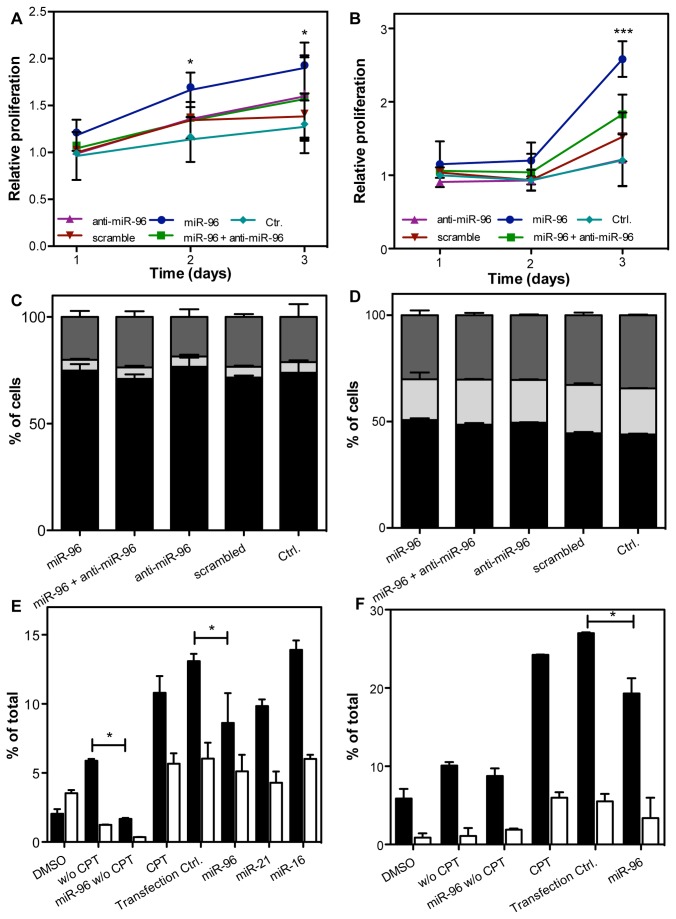
Functional role of miR-96 in vitro.LNCaP and DU145 cells were transfected with 10 nM pre-miR-96, anti-miR-96, pre-miR-NC #1 or combination of pre-miR-96 and anti-miR-96. The effect in (A) LNCaP and (B) DU145 on cell proliferation under serum starvation was measured by MTT assay over three days. All data were normalized on proliferation of control cultures on day 1 and are shown as mean (±SD) of three independent assays. *P <0.05, Two-way ANOVA. Cell cycle transition was measured by PI staining in transfected (C) LNCaP and (D) DU145 cells. Cells were serum starved one day after transfection for another 24 hrs and subsequently fixed and stained. Black, G1-phase; light grey, S-phase; dark grey, G2/M-phase. Data are shown as mean of three independent assays. Apoptosis in CPT-treated (E) LNCaP and (F) DU145 cells. 24 h after transfection cells were treated with 10 µM CPT for 24 h. Cells were stained with Annexin V-FITC and PI. Fraction of early (black bars) and late (white bars) apoptotic cells was measured by flow cytometry. Data are shown as mean (+SD) of three independent assays. *P <0.05; Bonferroni post-test (P < 0.001, Two-way ANOVA).